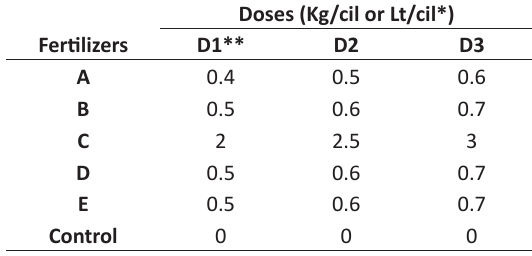
Table 3. Fertilizers used with their respective levels in SAVSA. Virú, La Libertad - Perú, May - June.